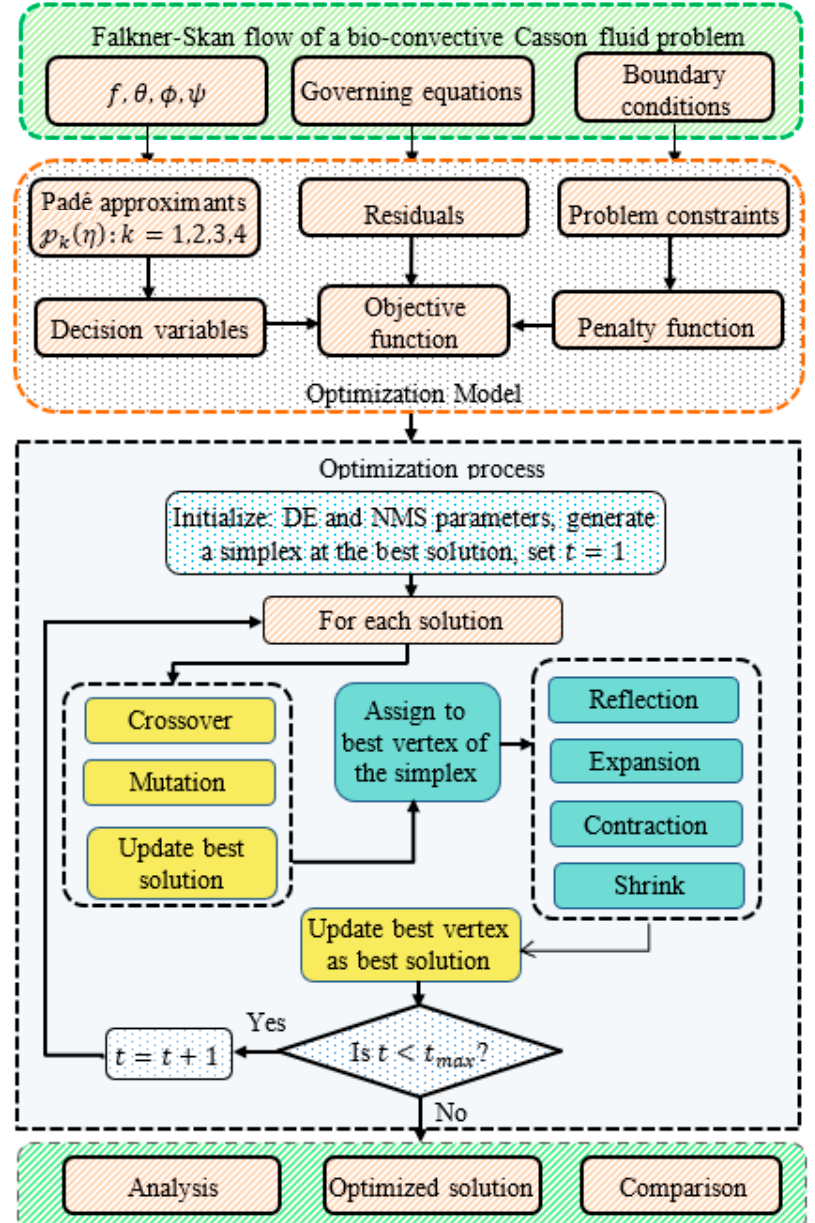
Figure 3. Schematic diagram of EPA scheme.